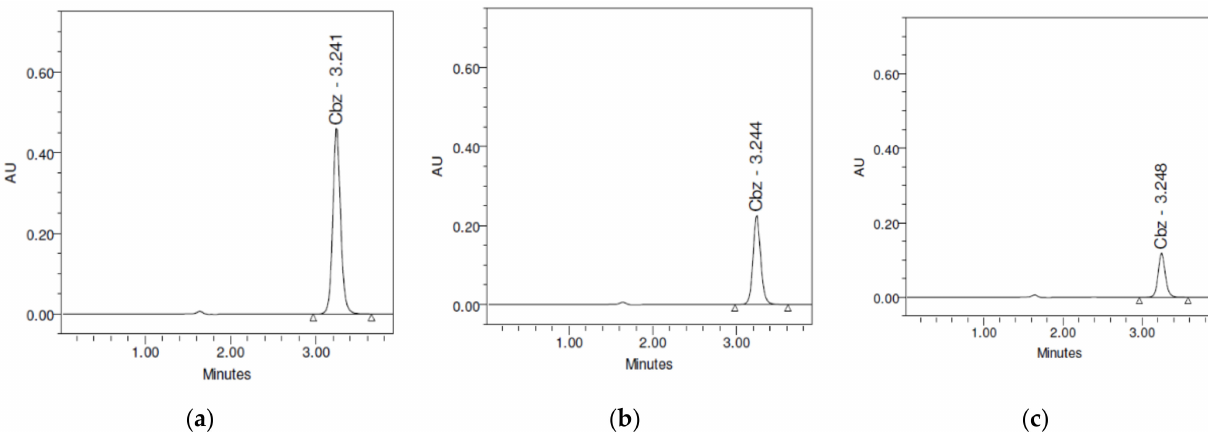
Figure 7. Representative chromatograms of ( a ) the carbamazepine assay; ( b ) a sample obtained in the study of carba- mazepine in vitro release kinetics from the CBZ- β -CD chewable tablets in simulated saliva (t = 15 min); ( c ) a sample obtained in the study of carbamazepine in vitro release kinetics from the CBZ- β -CD chewable tablets in 1% LSS (t = 15